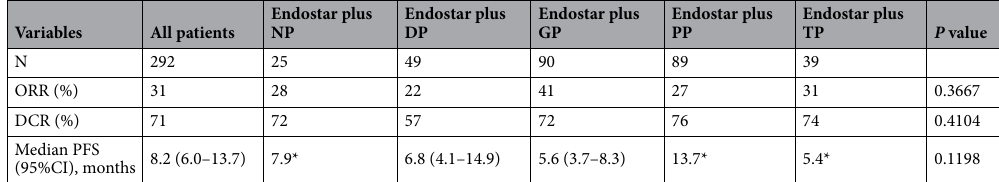
Table 3. The ORRs, DCRs and PFSs of Endostar plus different chemotherapy in all patients. * Too few people to estimate confidence intervals.